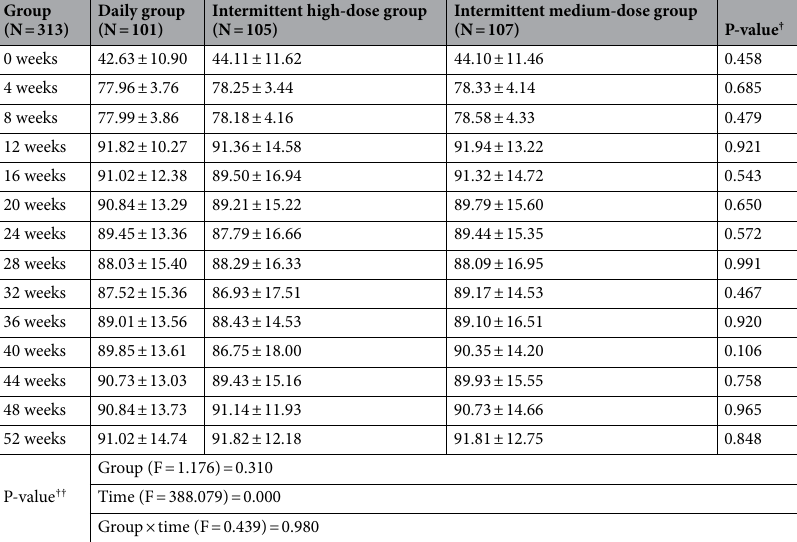
Table 2. Comparison of the TRACK scores of the children in the three groups at different time points (mean ± SD). There were no significant differences in the control rate at the same time point after treatment among the three groups (P > 0.05). † Multivariate analysis of variance. †† Repeated measures ANOVA.